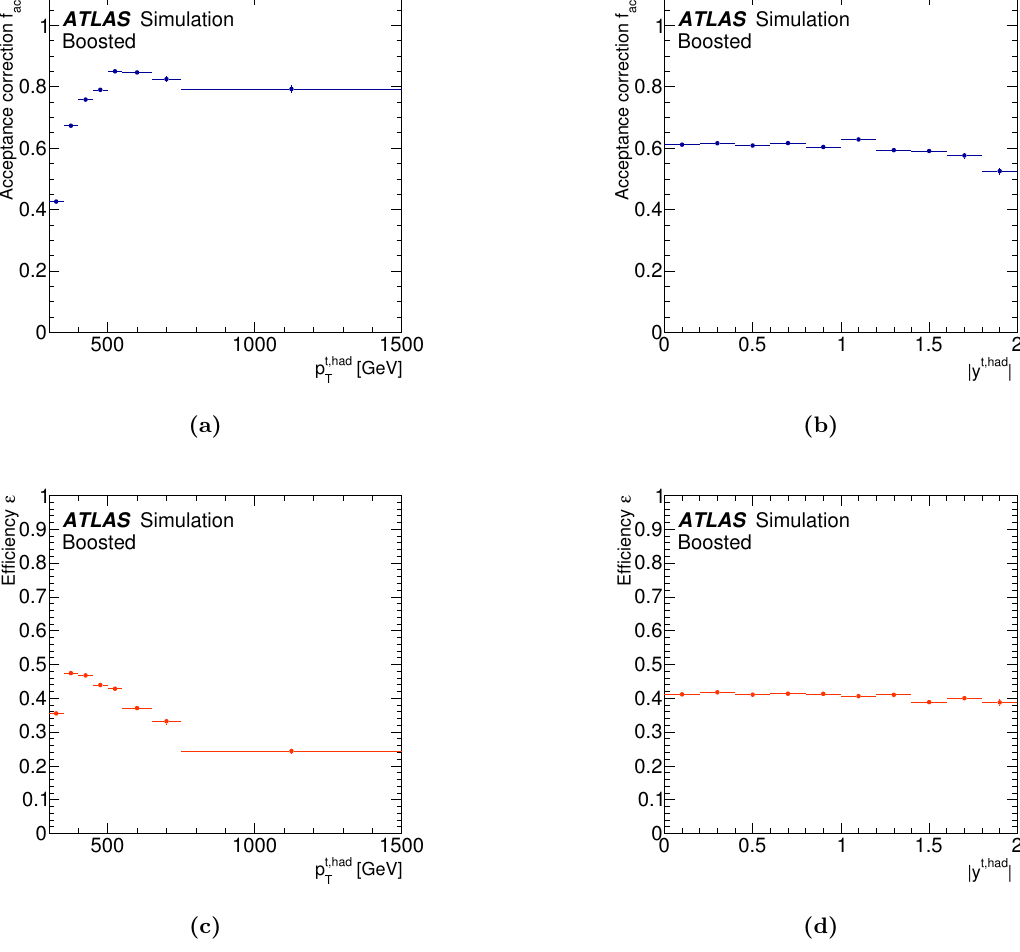
Figure 9. The acceptance correction for (a) the hadronic top-quark transverse momentum p t; had and (b) the absolute value of the rapidity top-quark transverse momentum p t; had